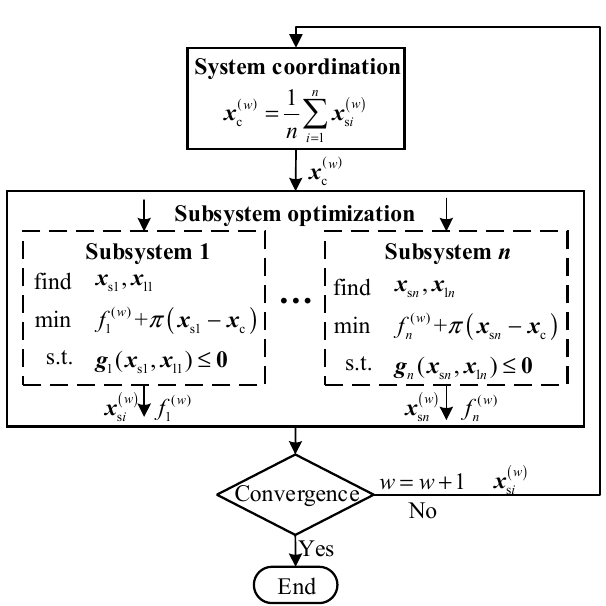
Figure 4. The framework of the MVPM.